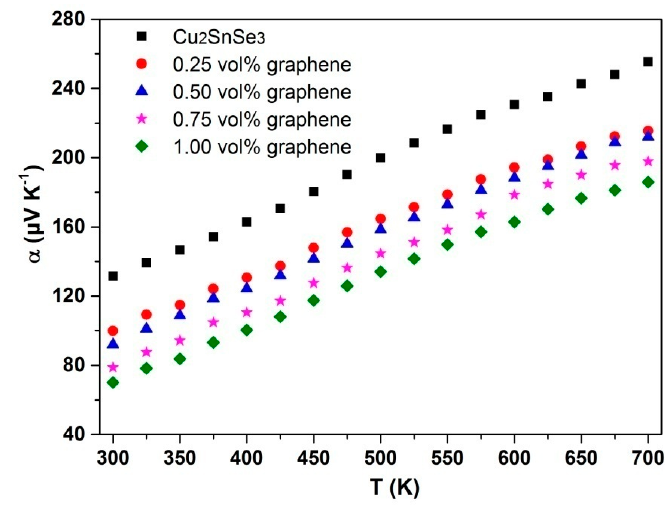
Figure 9. Seebeck coefficient ( α ) of graphene/Cu 2 SnSe 3 samples as a function of